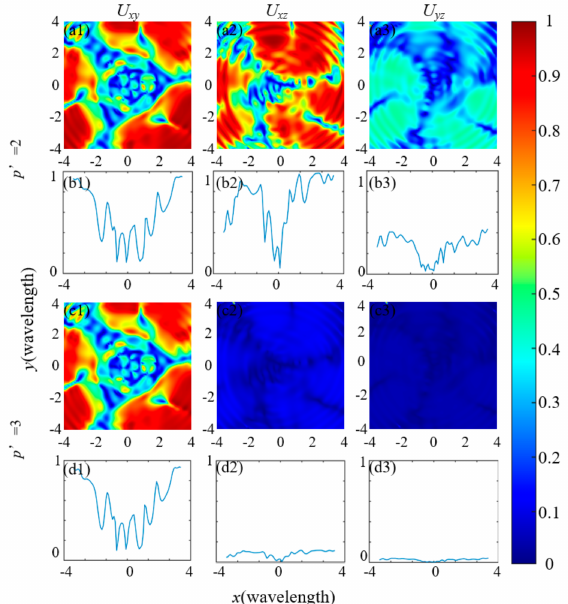
Figure 9. The degree of coherence between every component with different the order of LGSM p ’. ( l = 3, p = 1, δ = 0.015 m, and n = 4). Where, ( a1 – d1 ) the component U xy , ( a2 – d2 ) the component U xz , ( a3 – d3 ) the component U yz